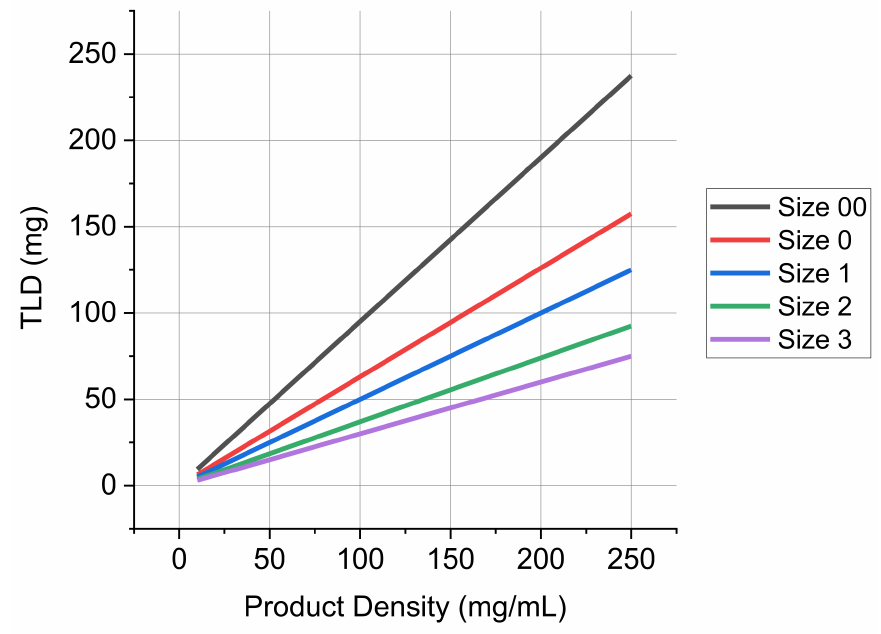
Figure 5. TLD as a function of the product density for various sized